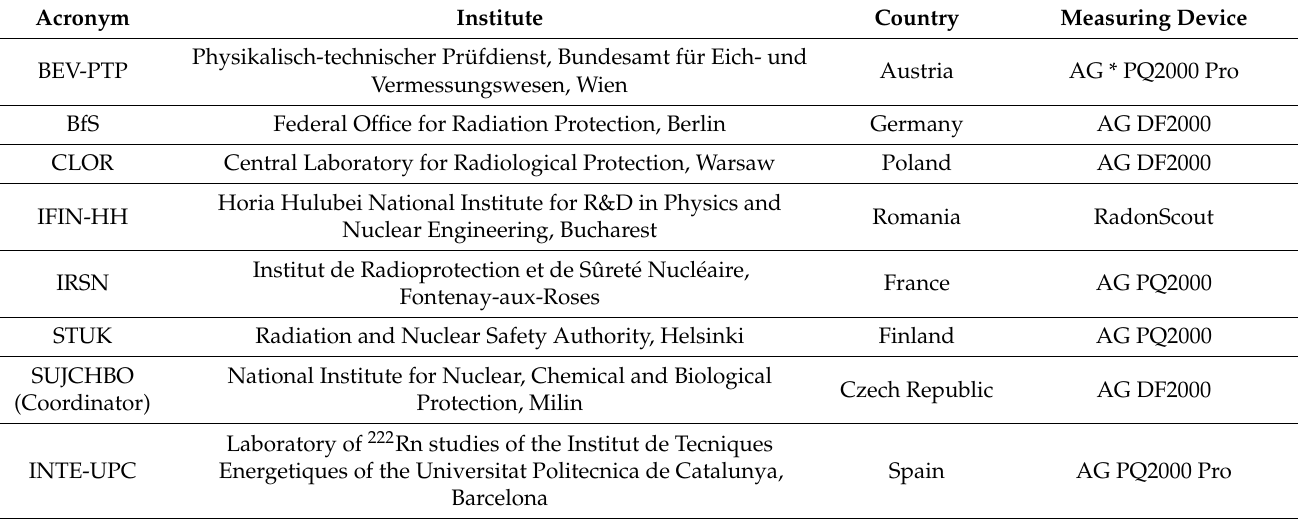
Table 1. Radon calibration facilities participating in the interlaboratory comparison (sorted alphabeti- cally by acronym) [7].